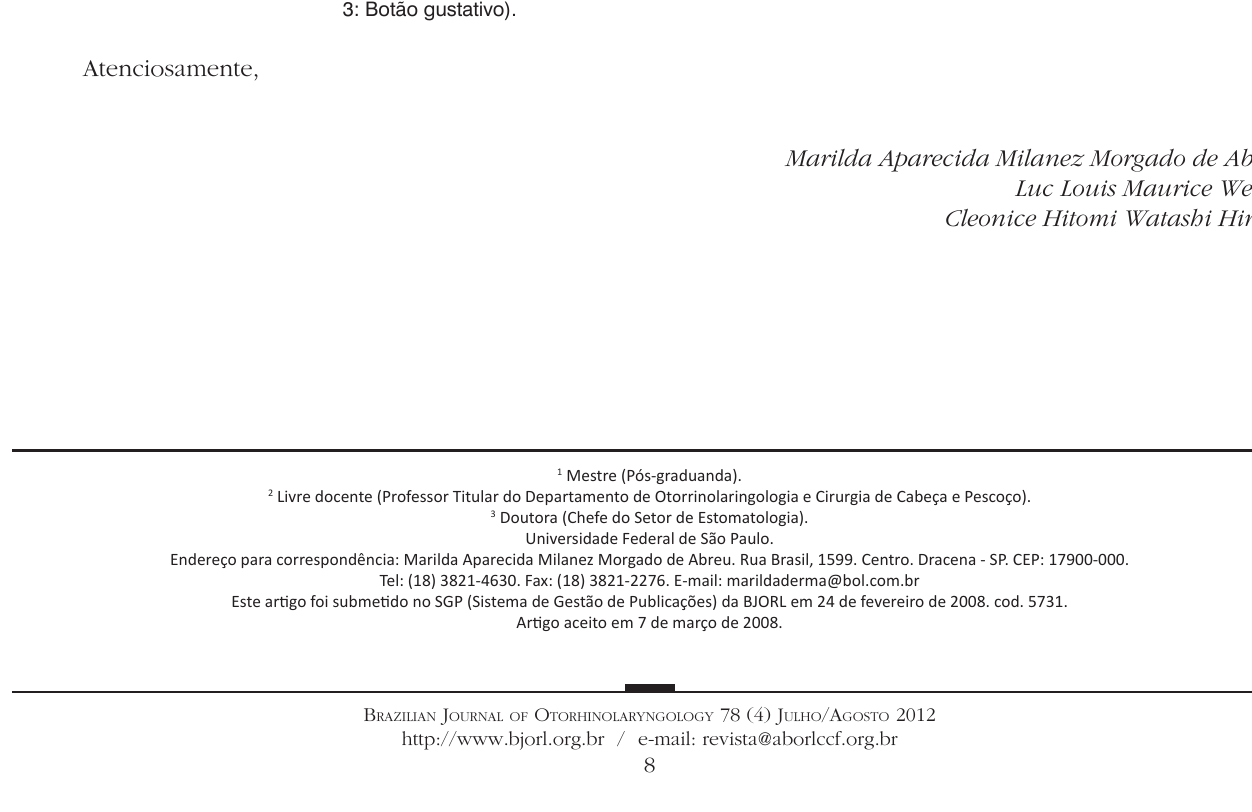
Figura 3. Papilas filiformes e papila fungiforme apresentando botão gustativo sobre o seu topo (1: Papila filiforme; 2: Papila fungiforme; 3: Botão